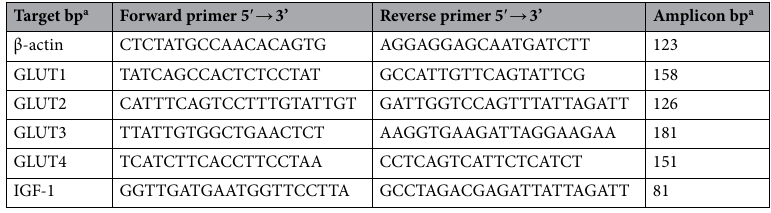
Table 2. Primers for real-time